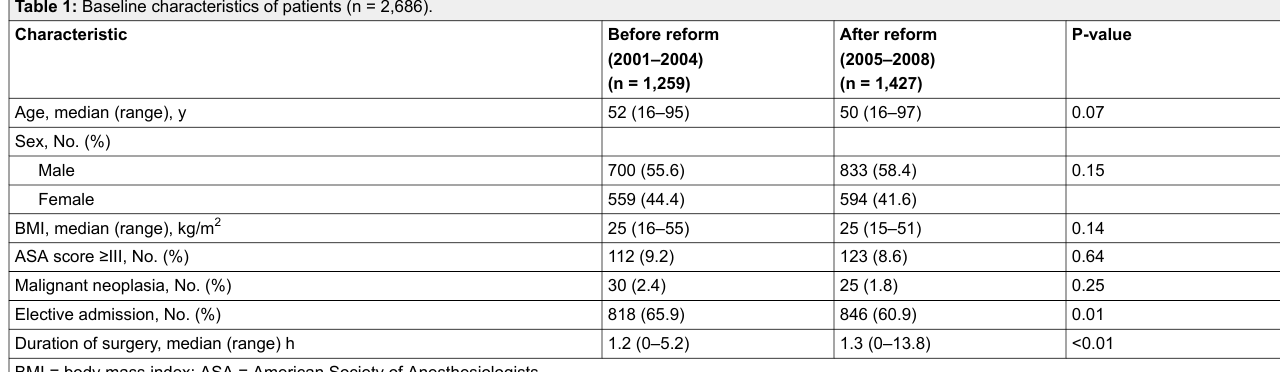
Table 1: Baseline characteristics of patients (n = 2,686).